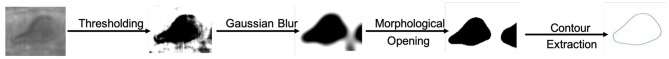
Image processing and contour extraction. Novel image processing were applied to obtain the erythrocyte contour for analysis. Briefly, image processing to obtain binary images involved the following: (1) contrast thresholding ([μi − σi, μi] → [0, 255], (2) Gaussian Smoothing (kernel: 5, σ = 7), (3) Thresholding (T = 68), (4) morphological opening (kernel: 3x3), and (5) binary edge detection for contour extraction.